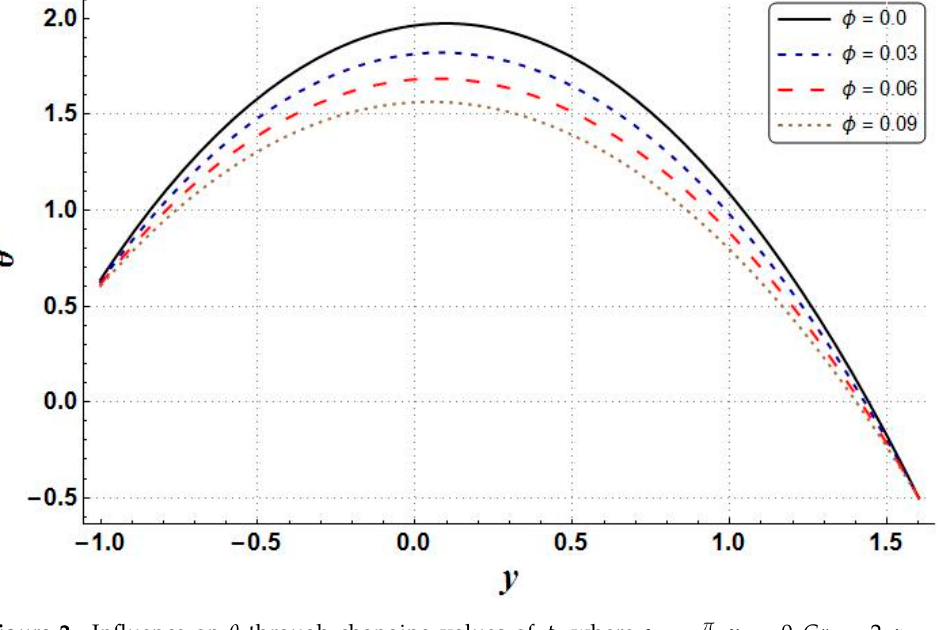
θ through changing values of